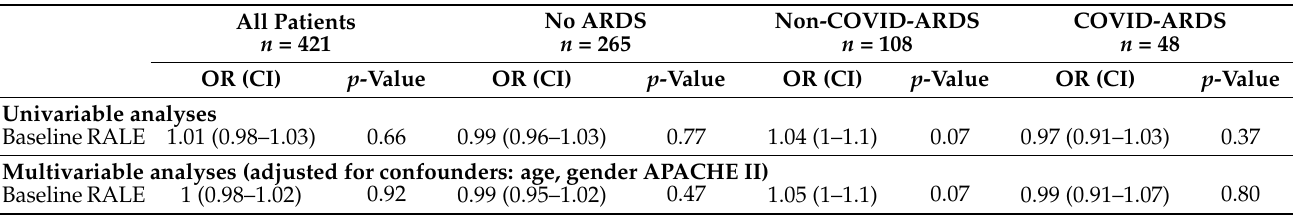
Figure 2. Distribution of baseline RALE scores. Data are stratified and coloured by predefined ARDS categories ( left ) and ARDS severity ( right ). Individual data points are displayed as dots. Distributions of the different groups are compared by means of a Mann–Whitney U test, which is displayed above the boxplots. RALE = Radiographic Assessment of Lung Edema; ARDS = Acute Respiratory Distress Syndrome; COVID = Coronavirus disease 2019. Table 2. Baseline RALE scores and 30-day mortality.